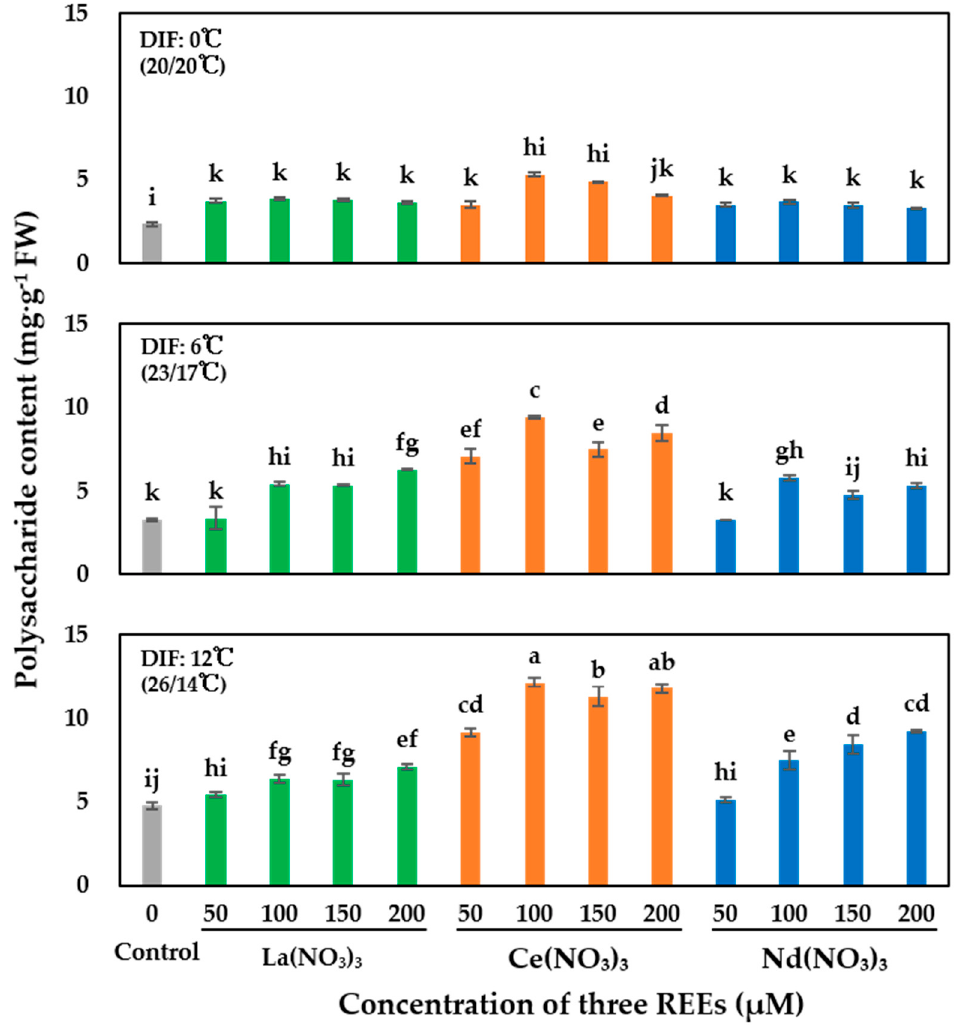
Figure 3. Effects of DIF and REE supplementation on polysaccharide content in D. aphyllum. The error bars represent the SEs of biological replicates (n = 3). Different letters within each panel indicate statistically significant differences at p = 0.05 using Duncan’s multiple range test.